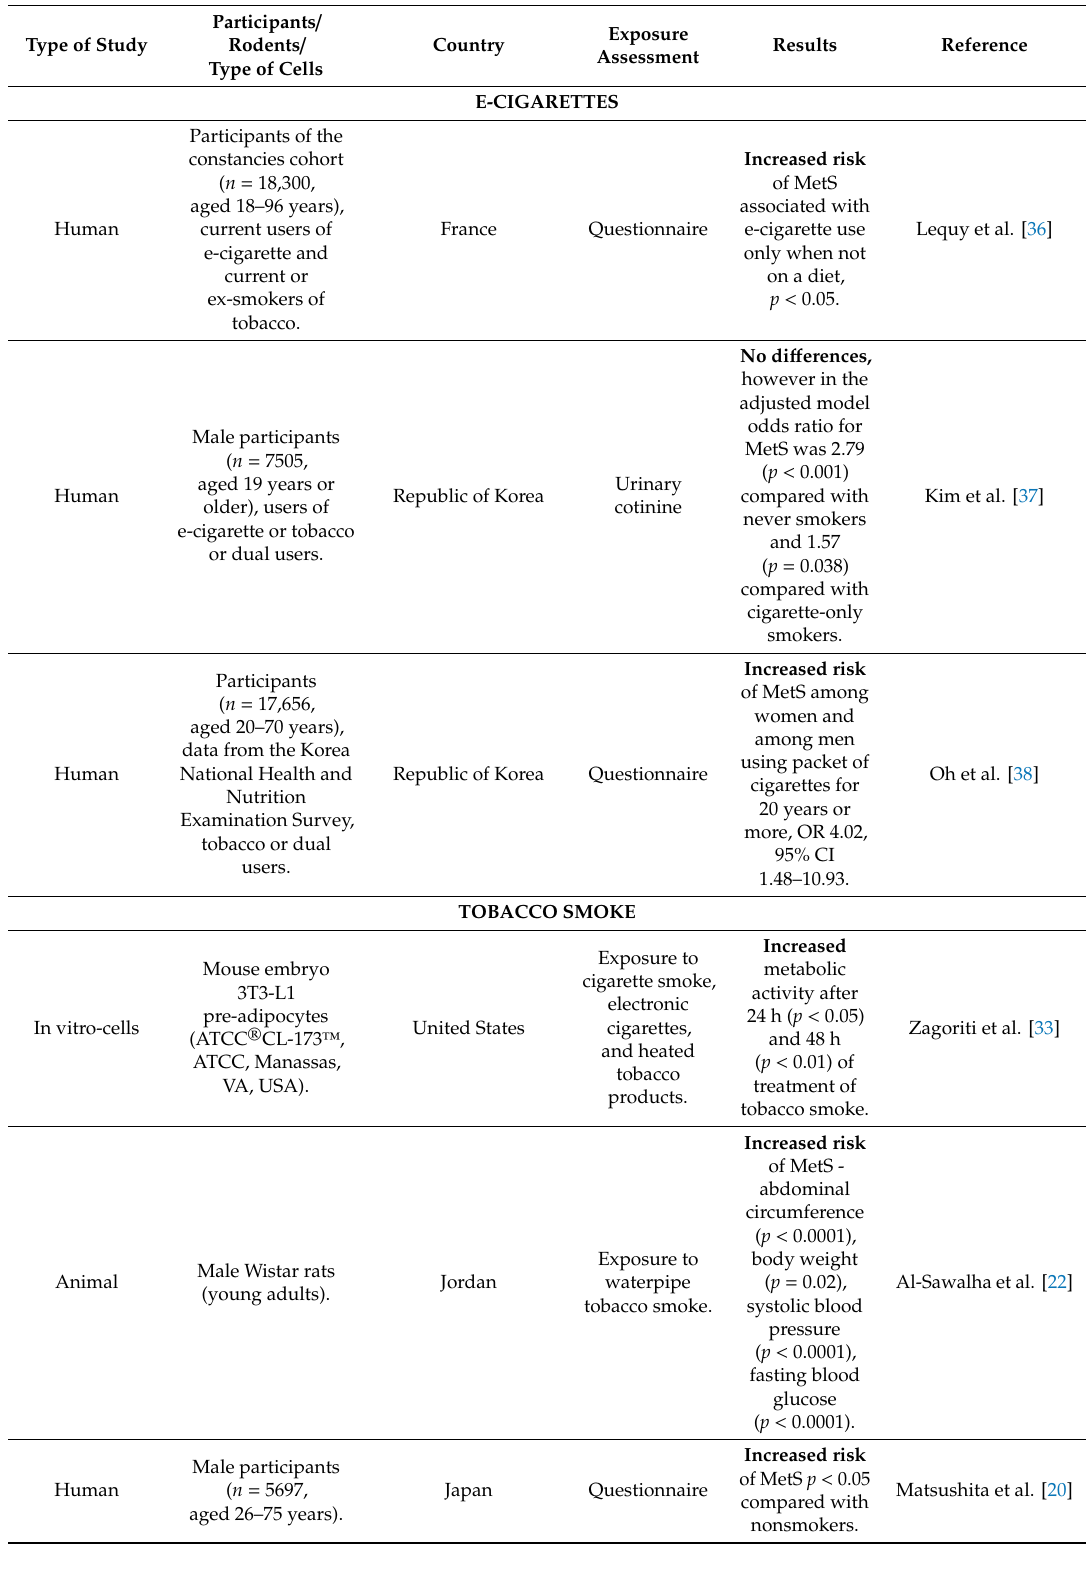
Table 2. The impact of electronic cigarettes use and tobacco smoke exposure on